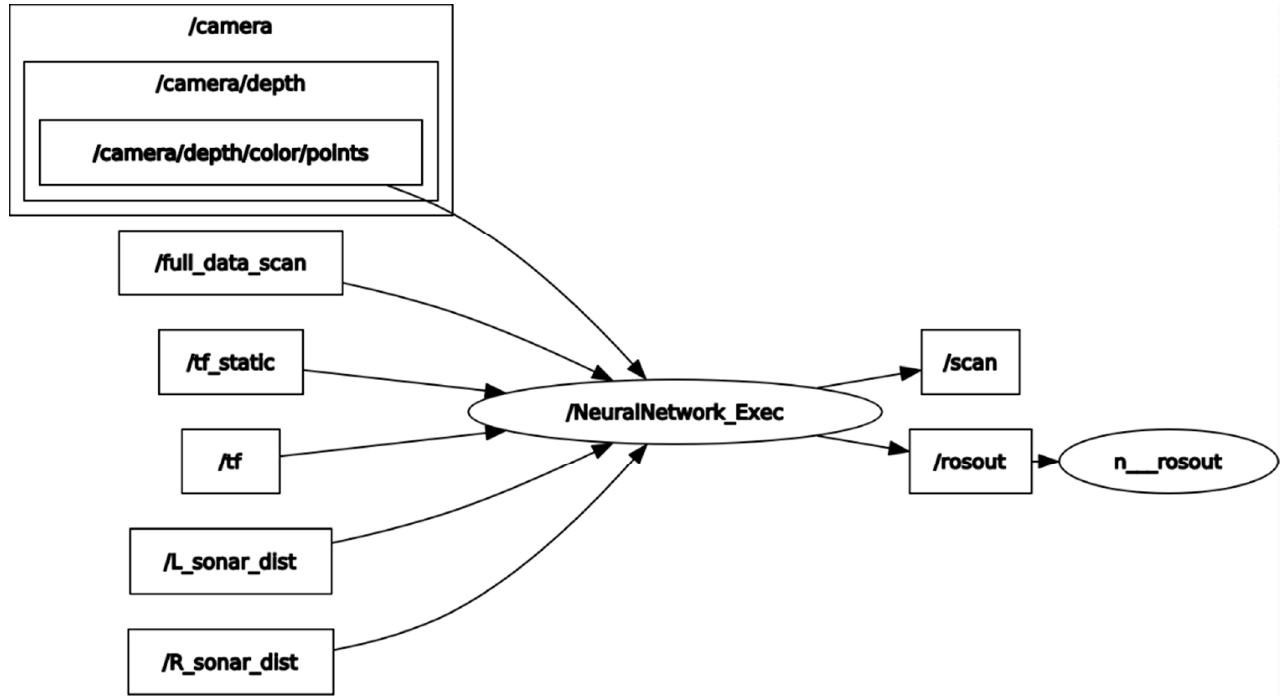
Figure 10. ROS node topology contribution.